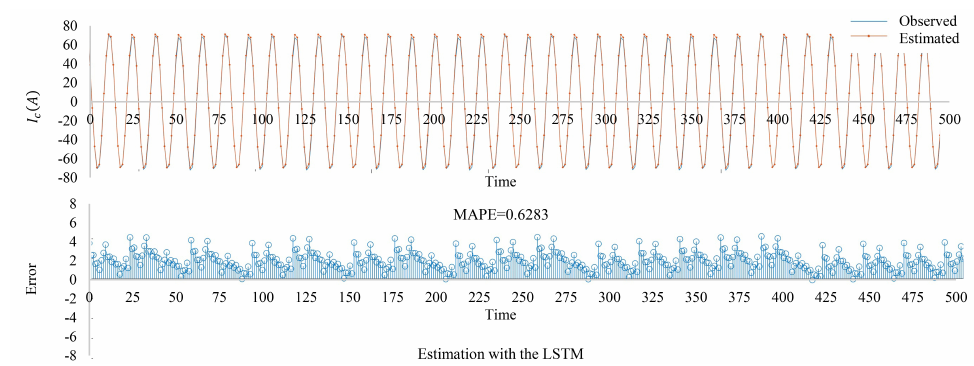
Figure 11. I c when the line-to-line fault occurs in I b and I c for the LSTM.